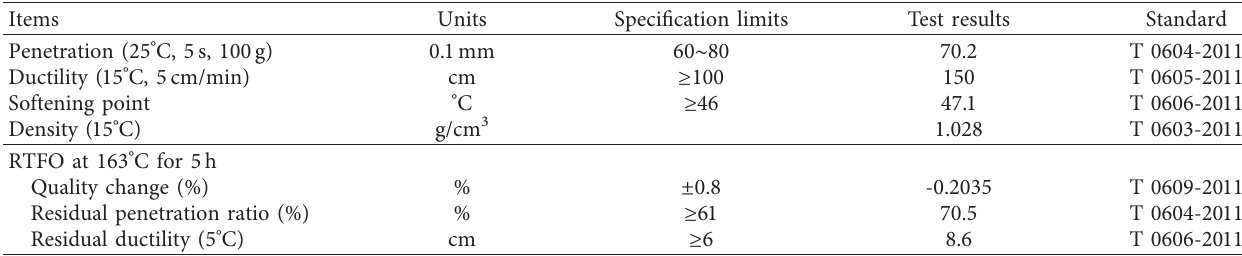
Table 3: Properties of asphalt material.